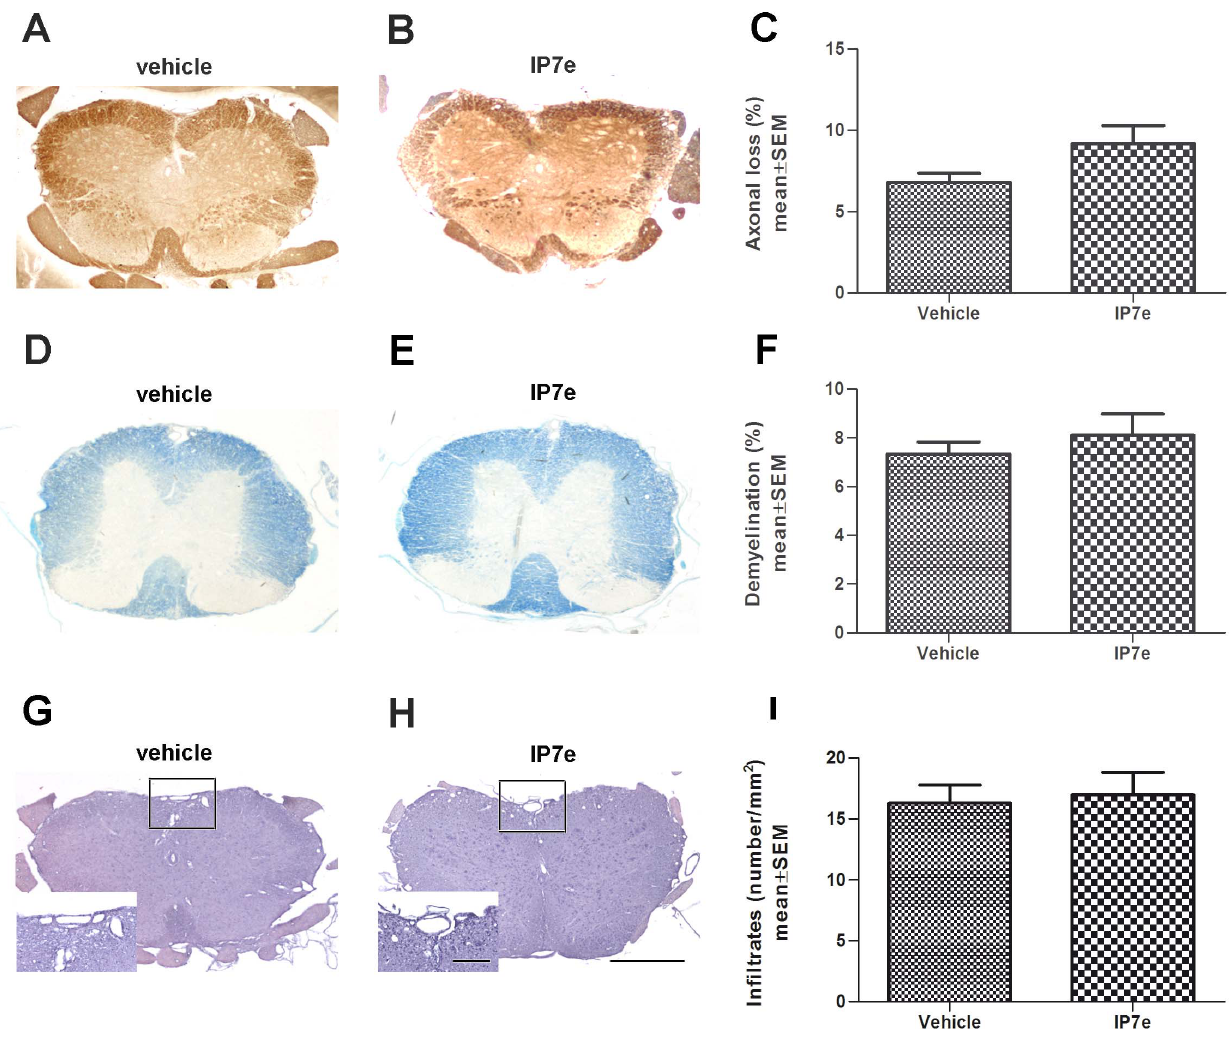
Figure 5. Therapeutic administration of IP7e does not influence EAE axonal loss, demyelination and, perivascular inflammatory infitration. Representative images of coronal sections of the spinal cord of IP7e (B, E, H) and vehicle (A, D, G) –treated EAE mice. Axonal damage, demyelination, and perivascular inflammatory infiltrates are measured using respectively Bielshowsky (A, B), Luxol fast Blue (D, E) and Hematoxylin and Eosin (G, H) staining in the spinal cord of IP7e (n=4) and vehicle (n=5) -treated EAE mice. Calibration bars, 25 m m and 250 m m. Quantification shows no differences in axonal loss (C), demyelination (F) and perivascular infiltrates (I) after the therapeutic administration of IP7e in EAE mice (Student’s t test). Data are expressed as mean 6 SEM. (IP7e; isoxazolo-pyridinone 7e, SEM; standard error of